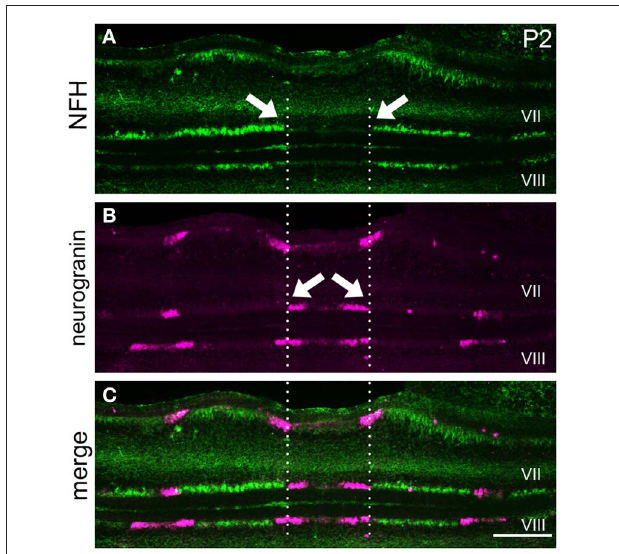
FIGURE 6 | NFH and neurogranin are expressed in complementary zones. (A) NFH is expressed in broad zones at P2. (B) Neurogranin is expressed in a series of early postnatal Purkinje cell zones. (C) The pattern of NFH is complementary to the pattern of neurogranin at P2. The arrows point to zonal boundaries and the vertical dotted lines highlight complementary domains at the midline. Scale bar = 250 μ m.